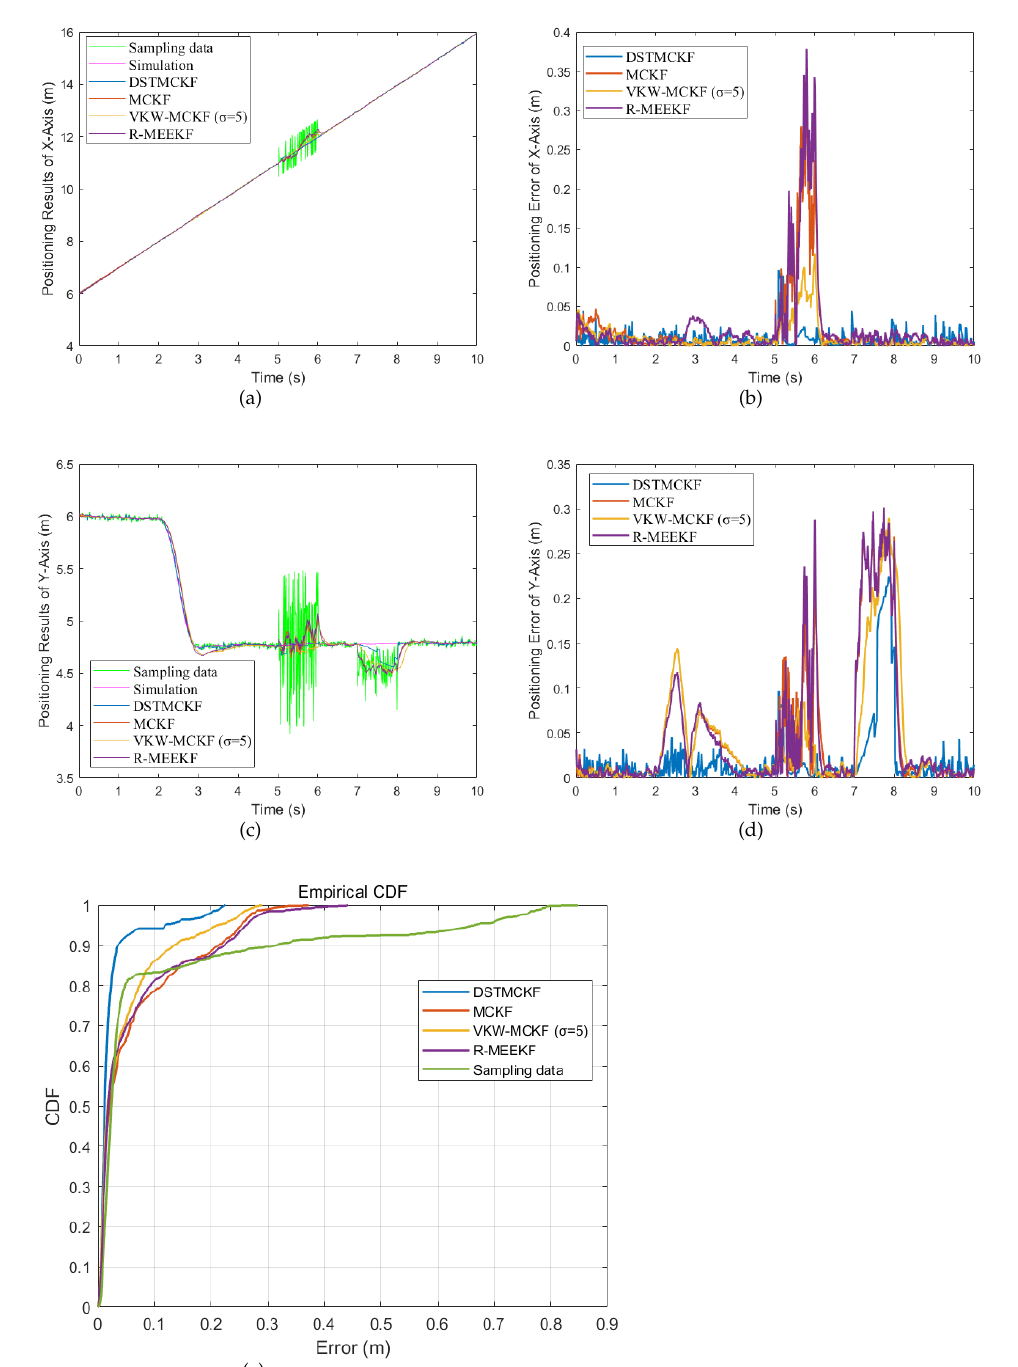
Figure 9. Simulation Results in Case (4). ( a ) Positioning result of X-label when σ = 1.2; ( b ) error of X-label when σ = 1.2; ( c ) positioning result of Y-label when σ = 1.2; ( d ) error of Y-label when σ = 1.2; ( e ) CDF of each filter when σ =